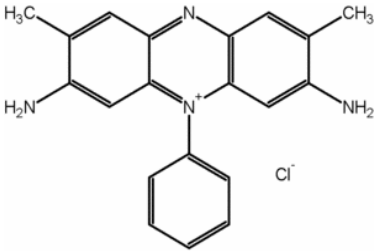
Figure 2. Structure of safranin